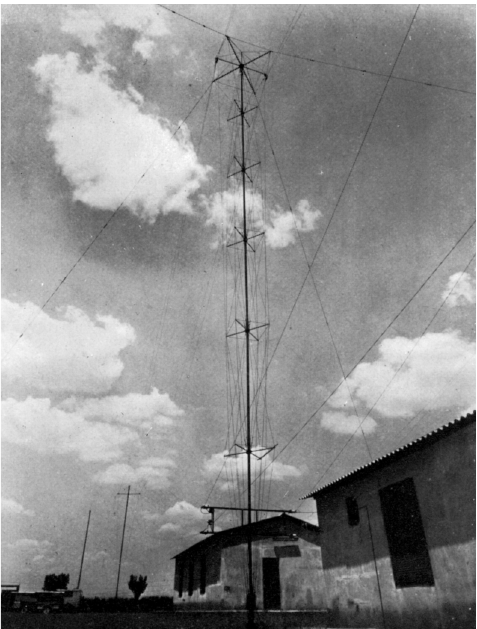
Fig. 3. A view of the antennas and huts for ionospher- ic vertical soundings in S. Alessio observatory (Rome, 1958) (from: Istituto Nazionale di Geofisica,